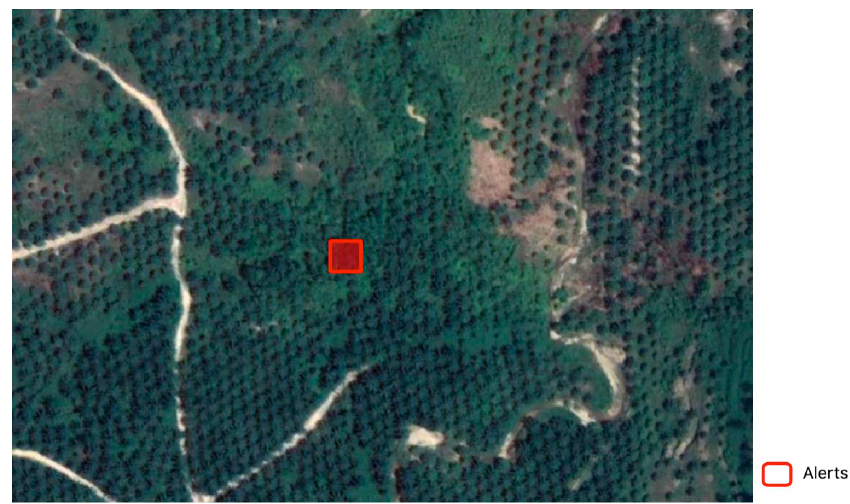
Figure 8. Alert inside the oil palm plantation.